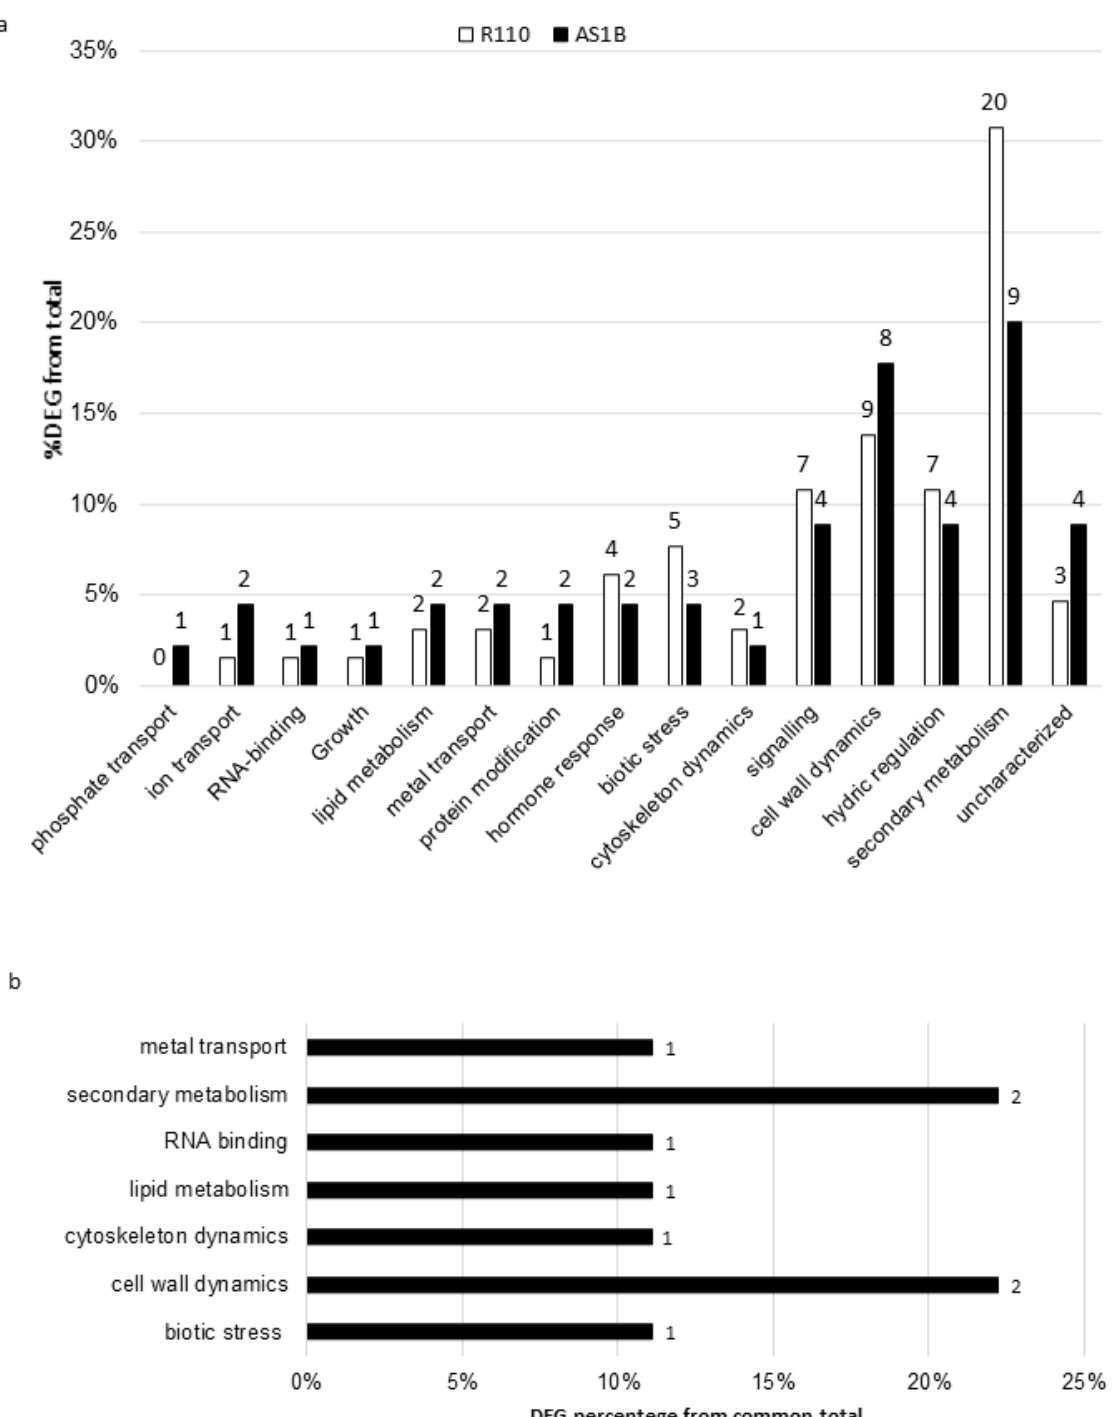
Figure 6. Functional distribution of AS1B and Richter 110 DEGs: DEGs by each accession ( a ); DEGs in common for both AS1B and Richter 110 ( b ). DEG percentages were calculated from the total amount of DEGs in each accession (45 DEGs for AS1B and 65 DEGs for Richter 110, with 9 DEGs among them). Numbers represented in the figure above and beside them represent the number of DEGs founded for each functional group.